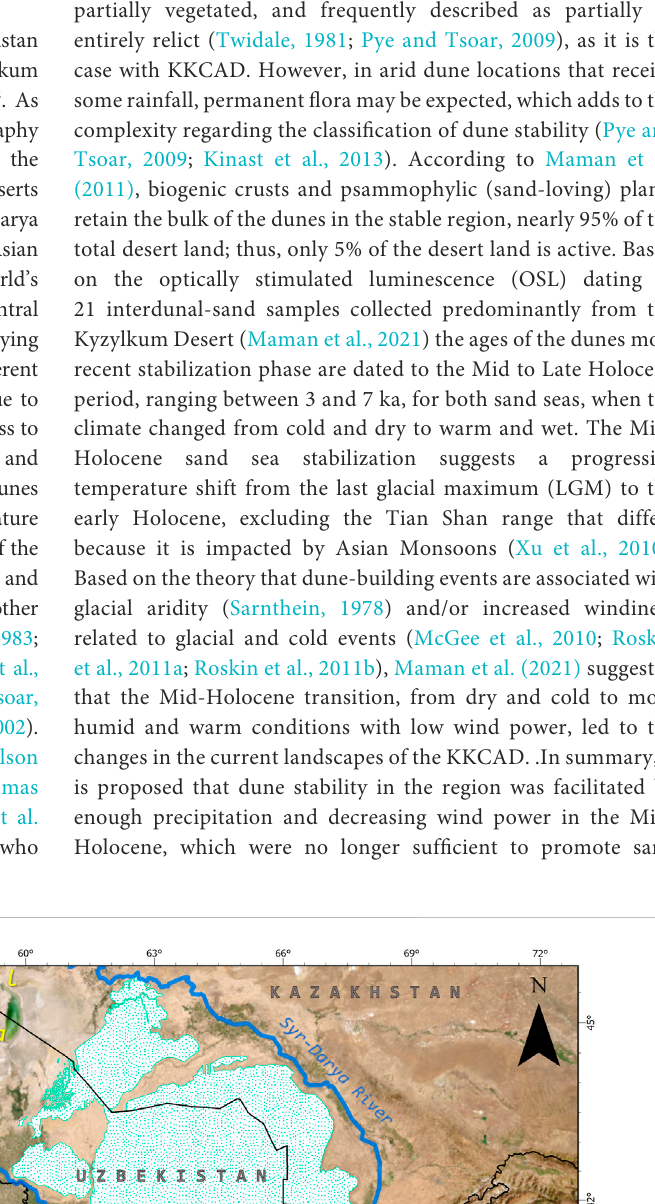
Frontiers in Earth